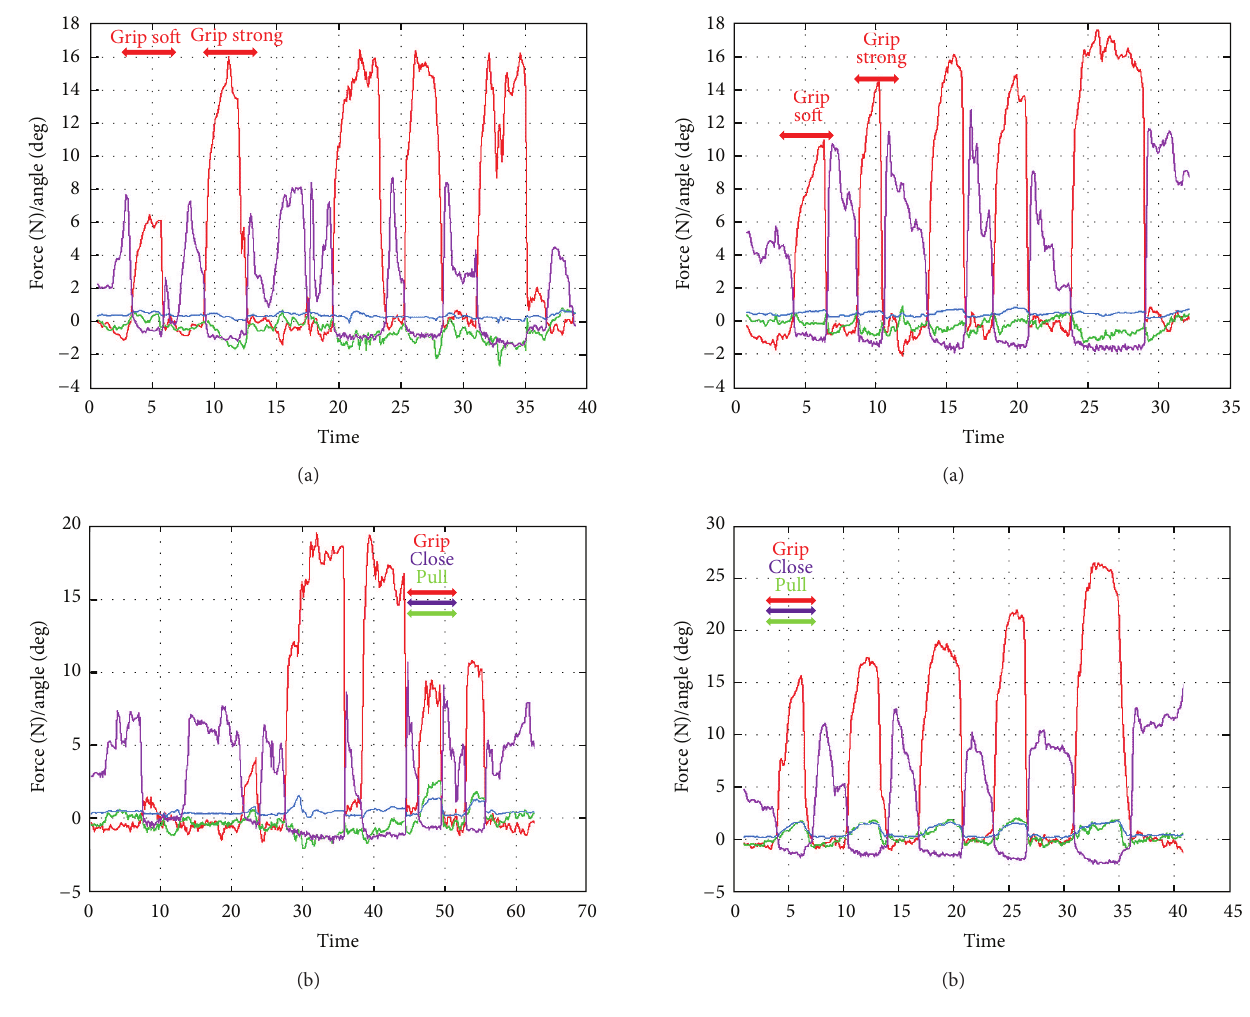
Figure 8: Experiment (C), grip and pull on the renal artery. Figure 9: Experiment (D), grip and pull on the renal vein.